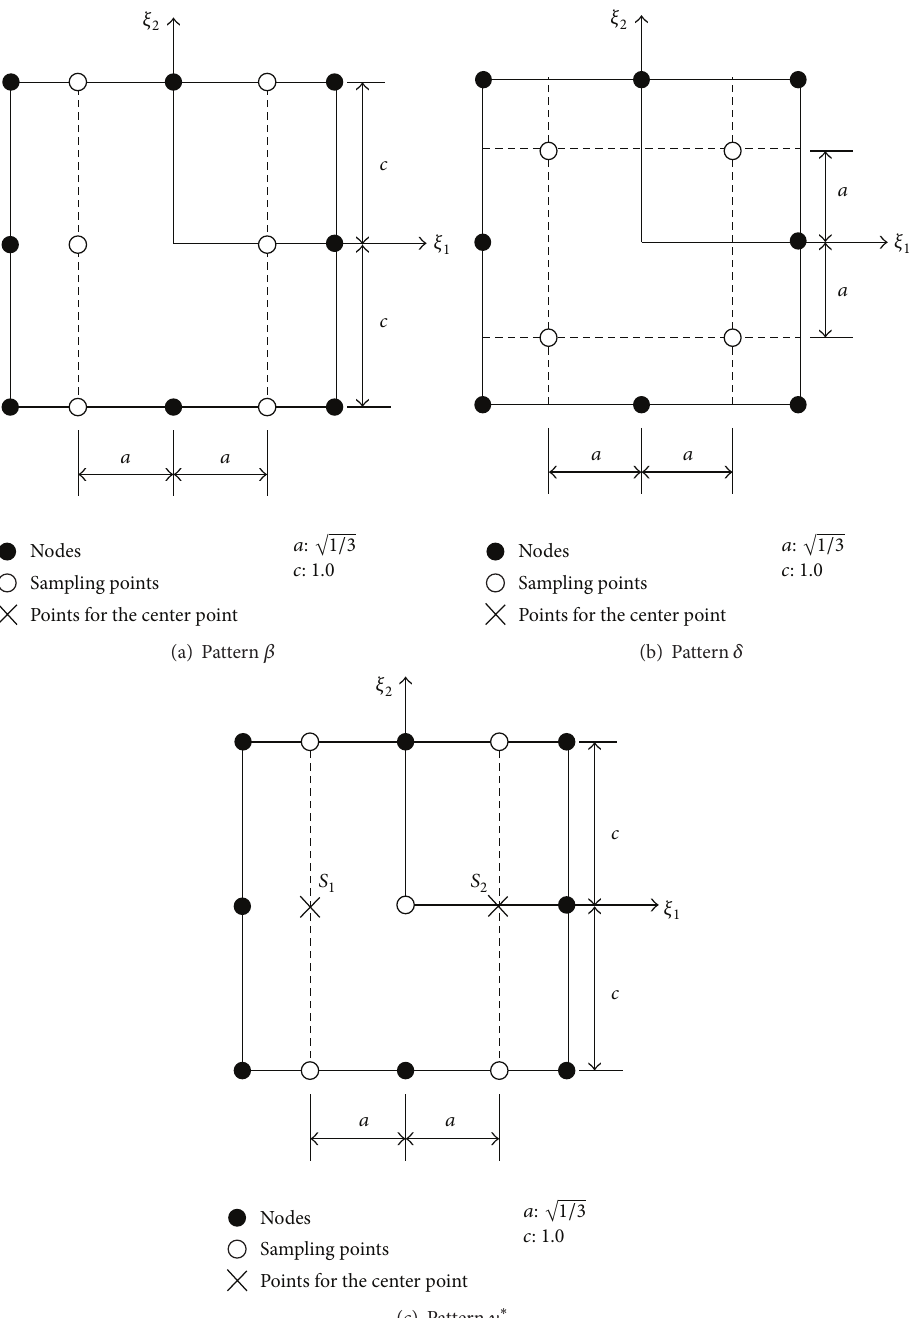
Figure 2: Four possible patterns of sampling points for 8-node ANS shell